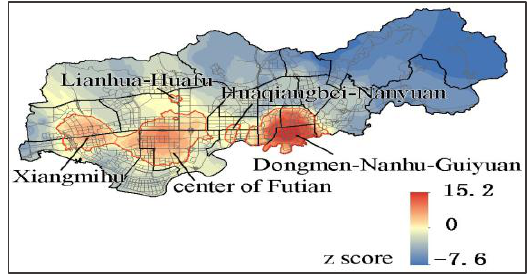
Figure 5. Local Accessibility Hot Spot Analysis Map of Malls.